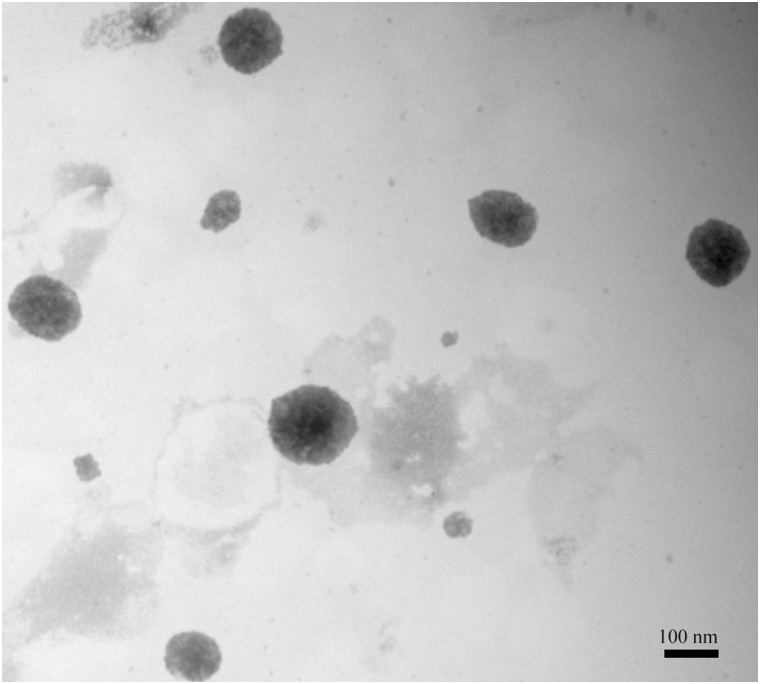
SCNT embryos-derived exosomes were identified by electron microscope analysis.Transmission Electron Microscopy (TEM) images showed the presence of exosomes after gradient centrifugations and negative staining with uranyl acetate. Bar, 100 nm.